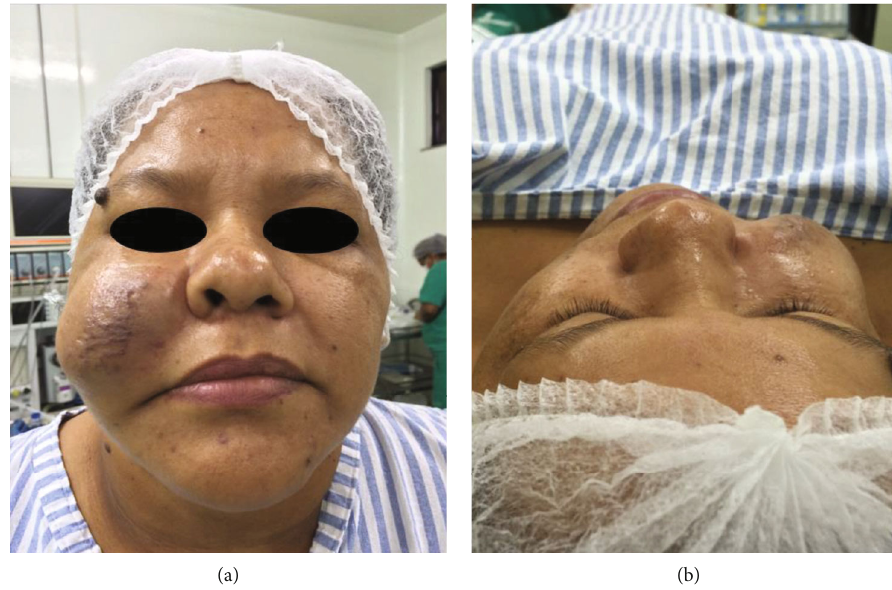
Figure 1: (a, b) Clinical aspect of the lesion, showing the large size of the growth.